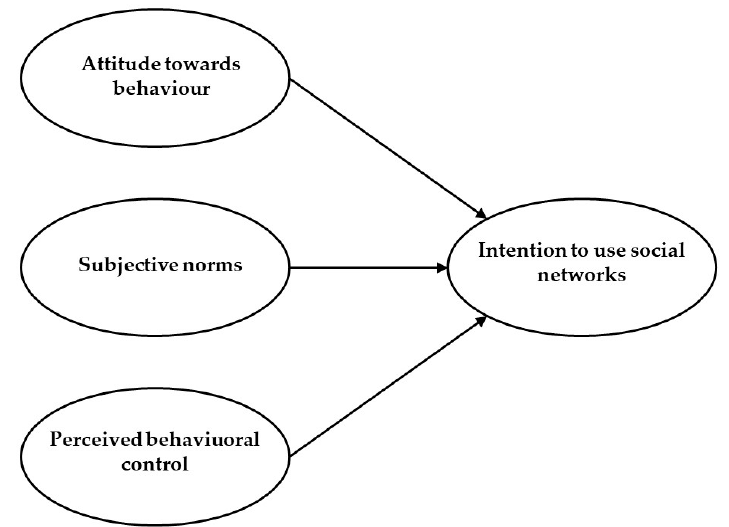
Figure 1. Research model, based on Theory of Plan Behaviour (TPB) .